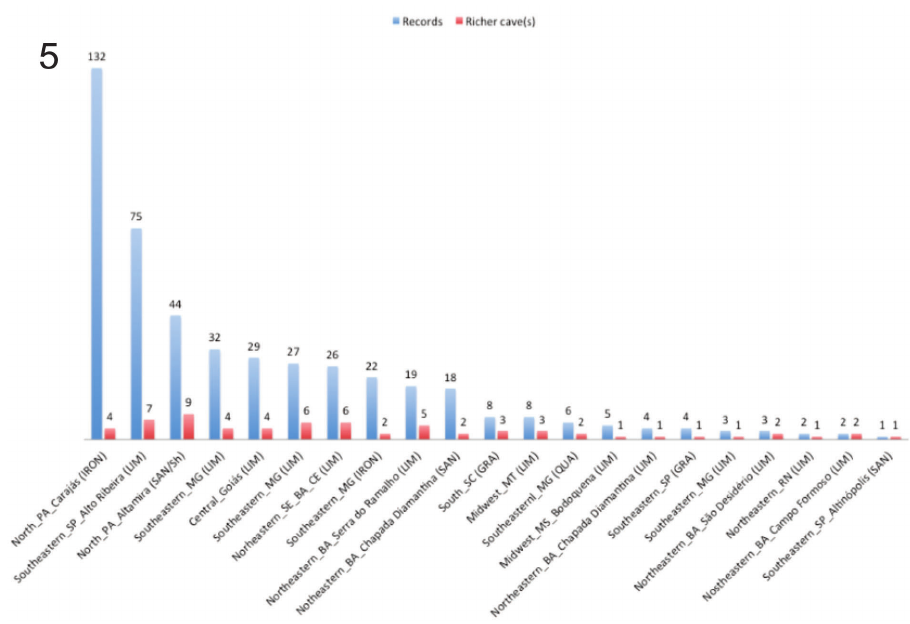
Figure 5. Total records per region and respectively richer caves. Lithologies: IRON, Iron ore; LIM, Limestone; SAN, Sandstone; Sh, Shale; GRA, Granitic; QUA, Quartzitic. States: PA, Pará; SP, São Paulo; MG, Minas Gerais; SE, Sergipe; BA, Bahia; CE, Ceará; SC, Santa Catarina; MT, Mato Grosso; MS, Mato Grosso do Sul; RN, Rio Grande do